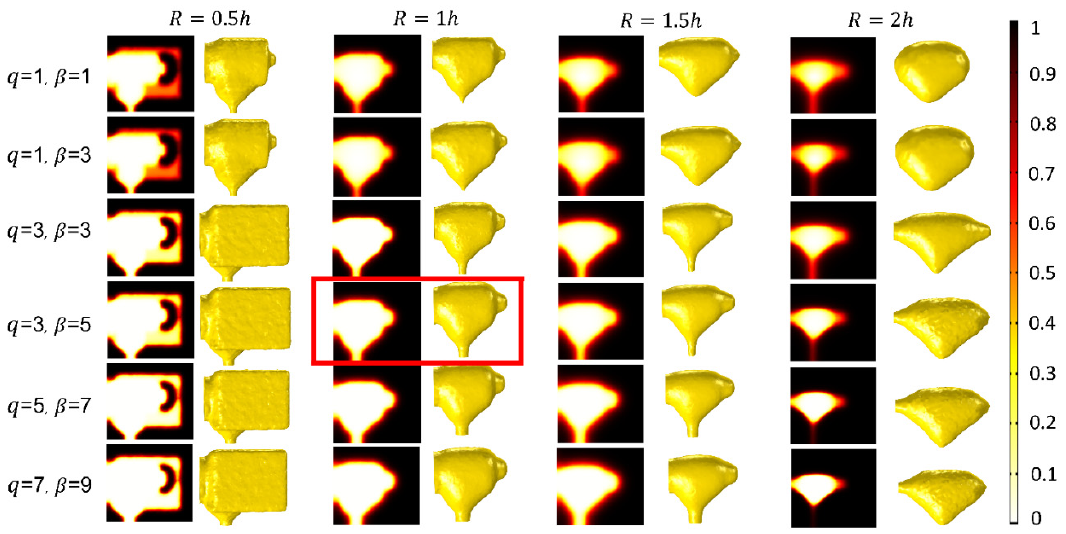
Figure 2. 2D and 3D reconstructed view list of the optimized shape with different q , β , and R parameters.